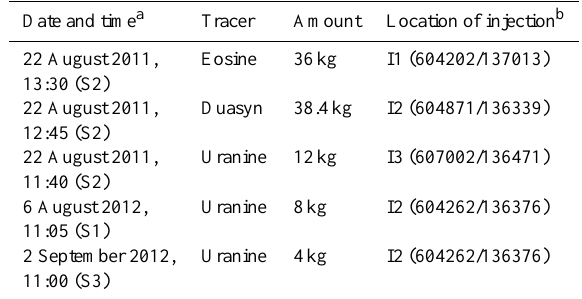
Table 2. Overview of the tracer